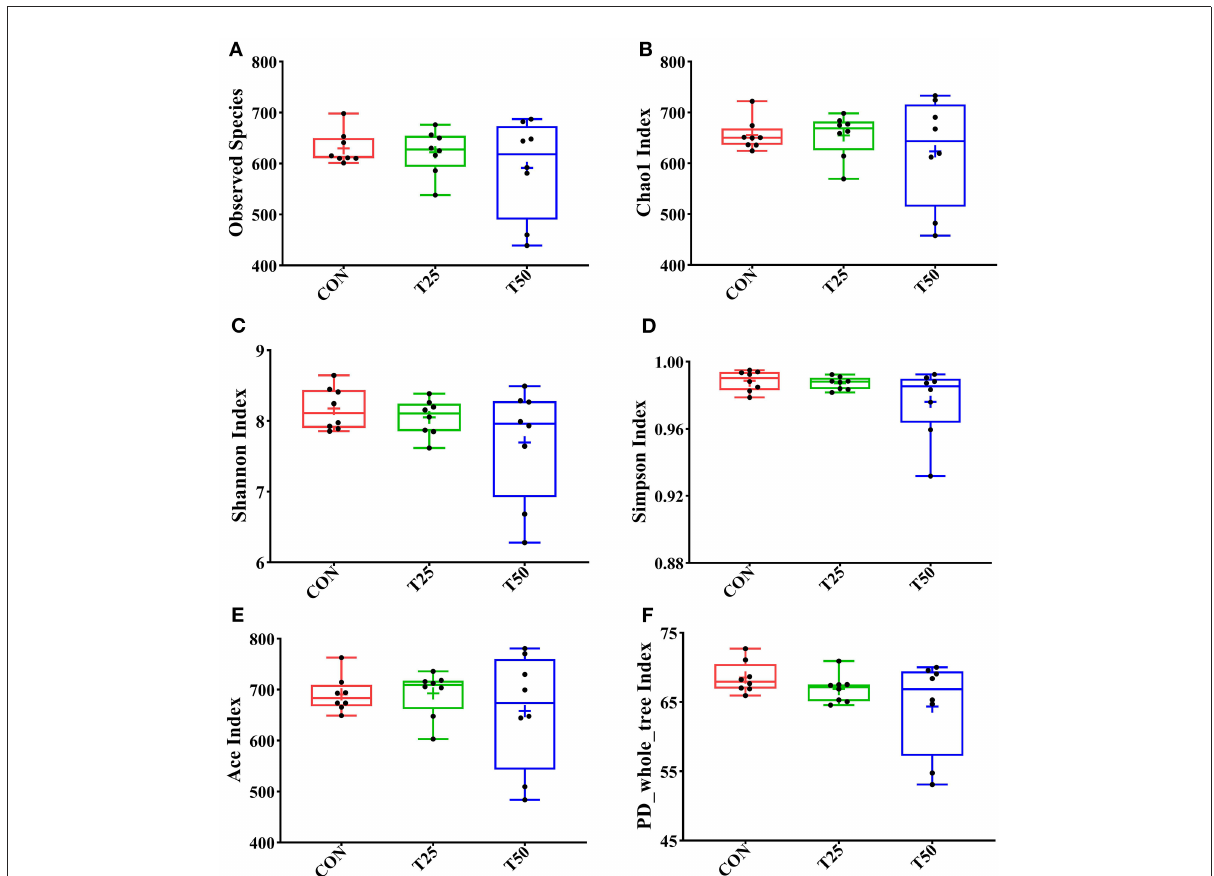
FIGURE5 Alpha diversity analysis of rumen flora. (A) The number of observed species; (B) Chao1 index of species richness; (C) Shannon index of species diversity; (D) Simpson index of diversity; (E) Ace index of species richness; and (F) phylogenetic tree index. The “ + ” symbol in the box plot represents the mean of the within-group exponent.